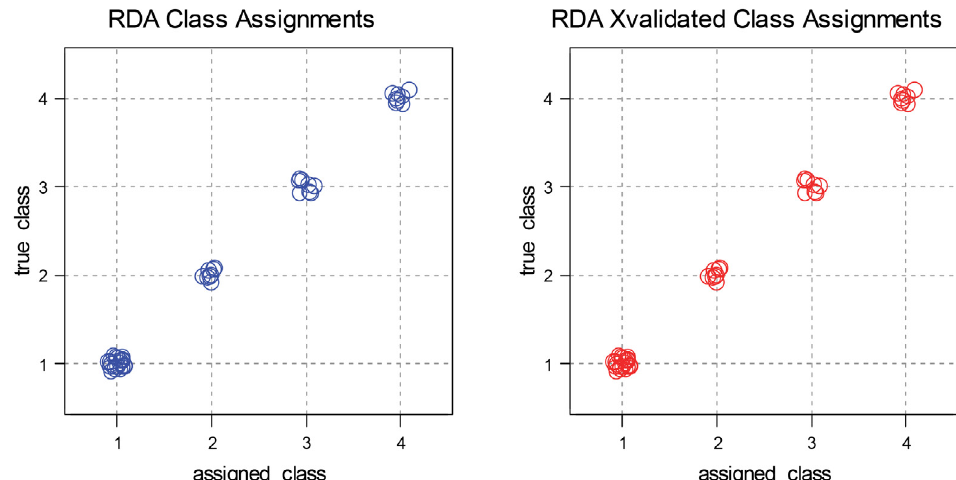
Figure 5. Classification of pure camelina oil and mixture clusters on the basis of the calculated RDA model and the results of validation model, using the cross-validation test. RDA model was calculated based on sterol composition. The RDA model was obtained based on sterol composition.